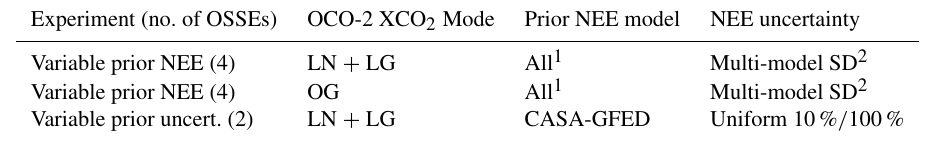
Table 2. Summary of the different OSSEs conducted during this work. Experiment (no. of